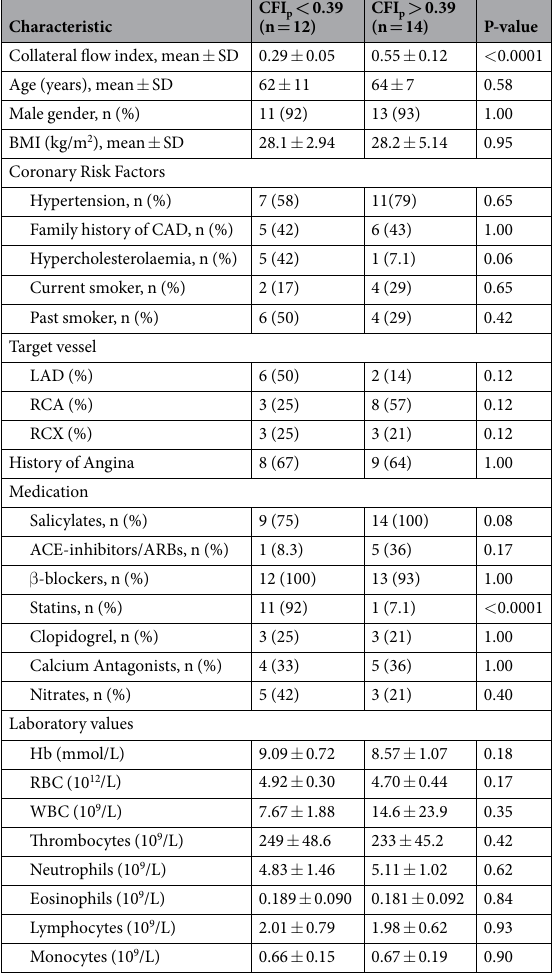
Table 1. Patient Characteristics. ACE, Angiotensin converting enzyme; ARBs, angiotensin receptor blockers; BMI, body mass index; CAD, coronary artery disease; CFI p , collateral flow index; Hb, hemoglobin; LAD, left anterior descending; RBC, red blood cells; RCA, right coronary artery; RCX, right circumflex; WBC, white blood